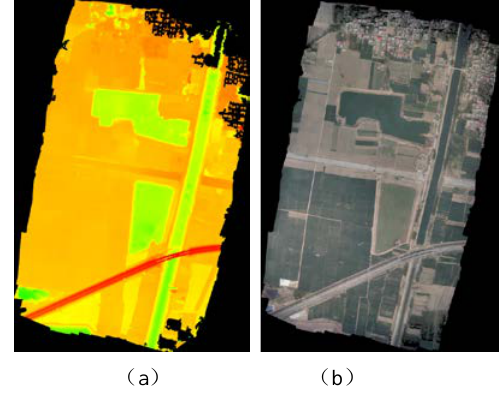
Figure 12. Digital Elevation Matrix and Digital Orthophoto